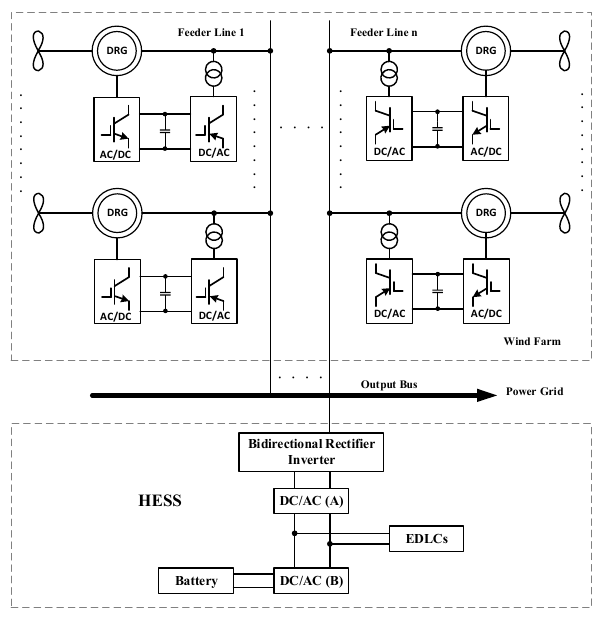
Figure 11. Power system consisting of wind power, electric double-layer capacitor (EDLC) and